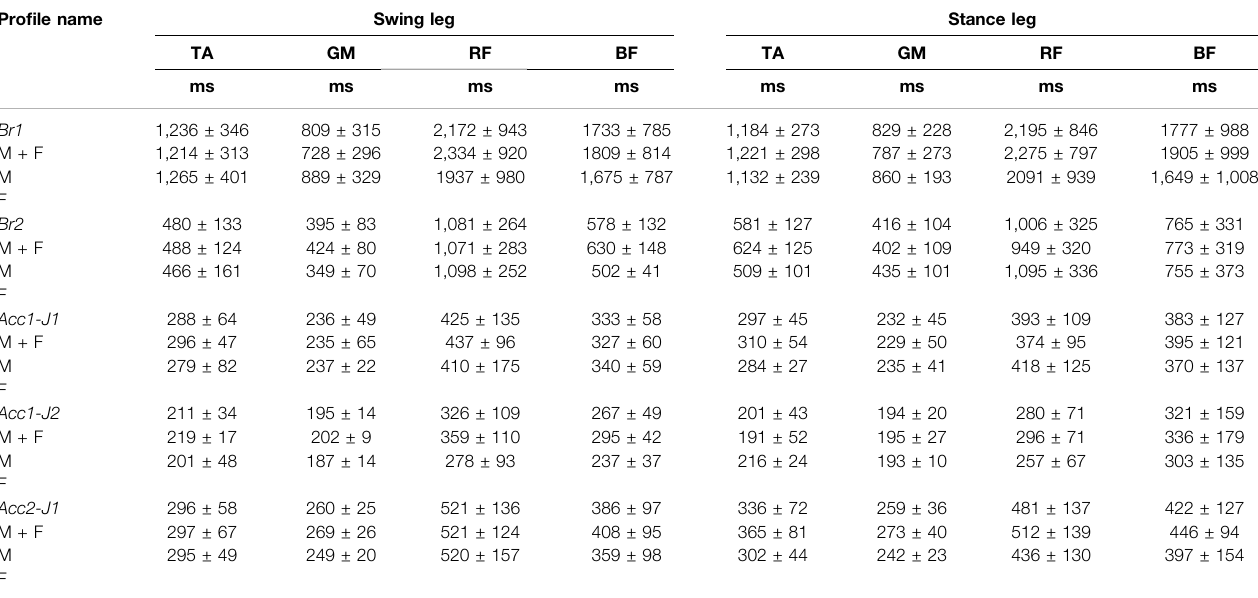
TABLE 6 | Descriptive statistics on EMG onset latencies in backward-direction trials (Males/Females, mean ±